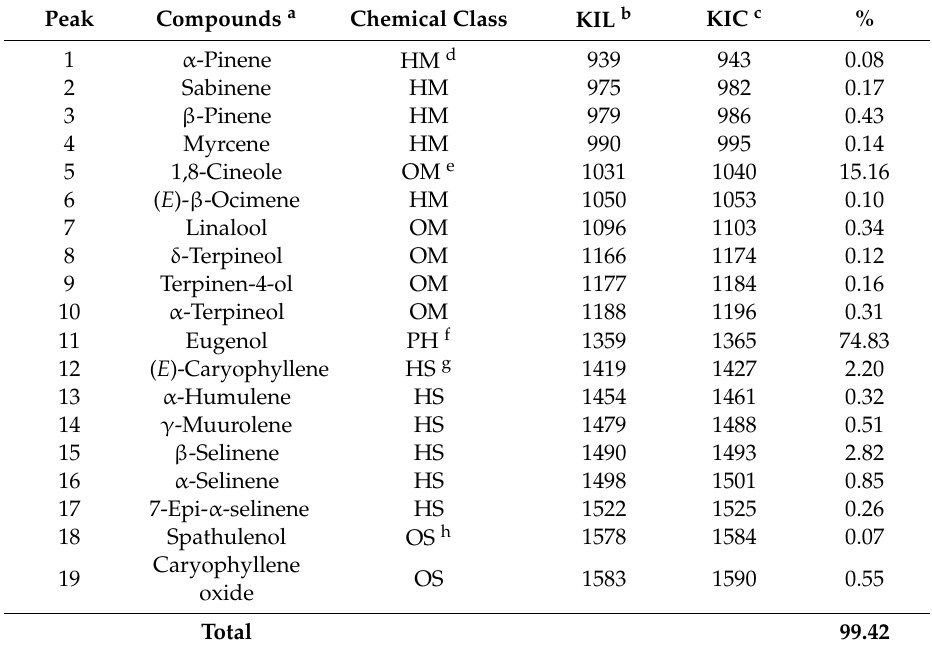
Table 1. Chemical composition from the essential oil (EO) of the Ocimum gratissimum L. (EOOG) leaves.